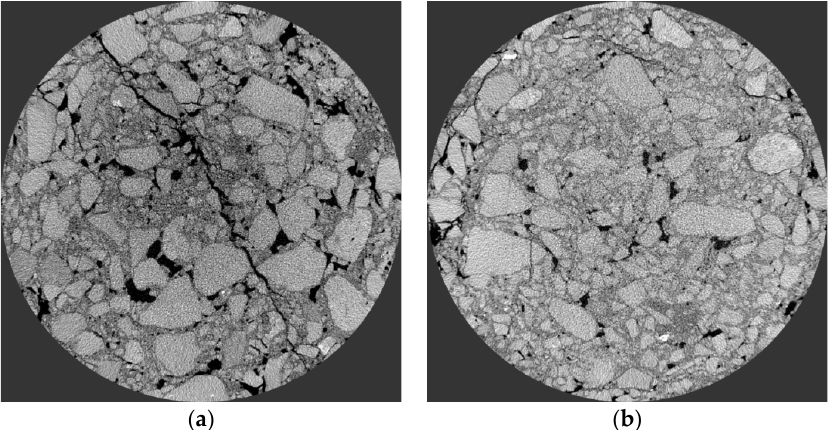
Figure 15. Fracture scanning maps under different loads. ( a ) After splitting test. ( b ) After uniaxial compression failure.